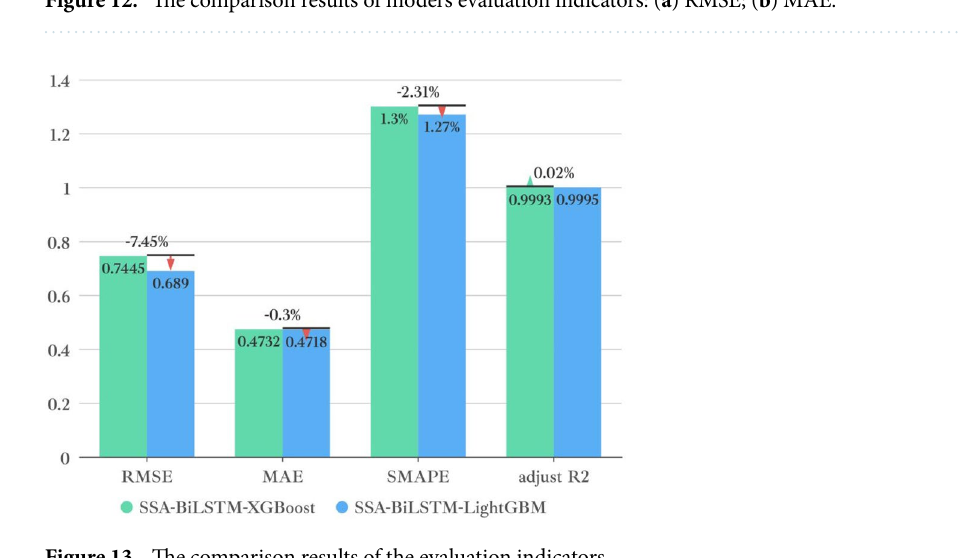
Figure 13. The comparison results of the evaluation indicators.